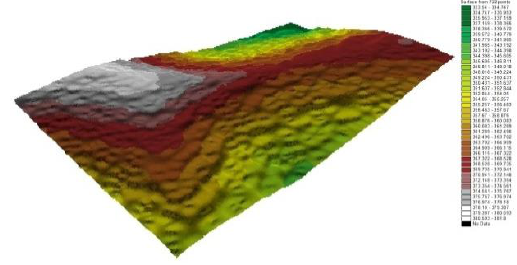
Figure 17. 3D for a DEM created from reduced LiDAR data of point cloud density down to 0.037pts/m 2 .